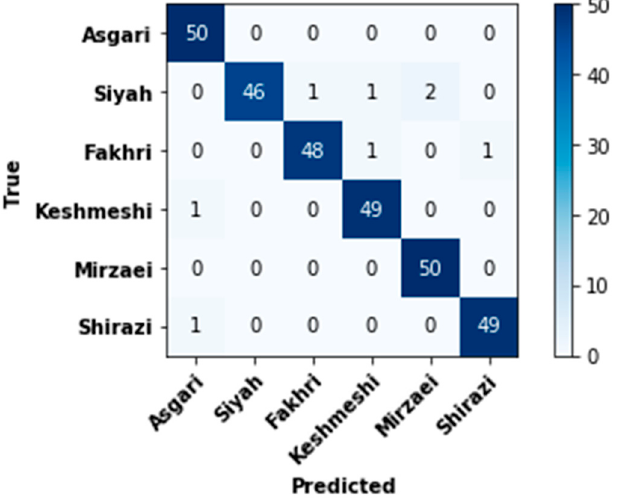
Figure 6. The sum of confusion matrices evaluated from the proposed convolutional neural network model with six classes. Table 3. Average statistical parameters and deviations of the selected convolutional neural network model. AUC = area under the